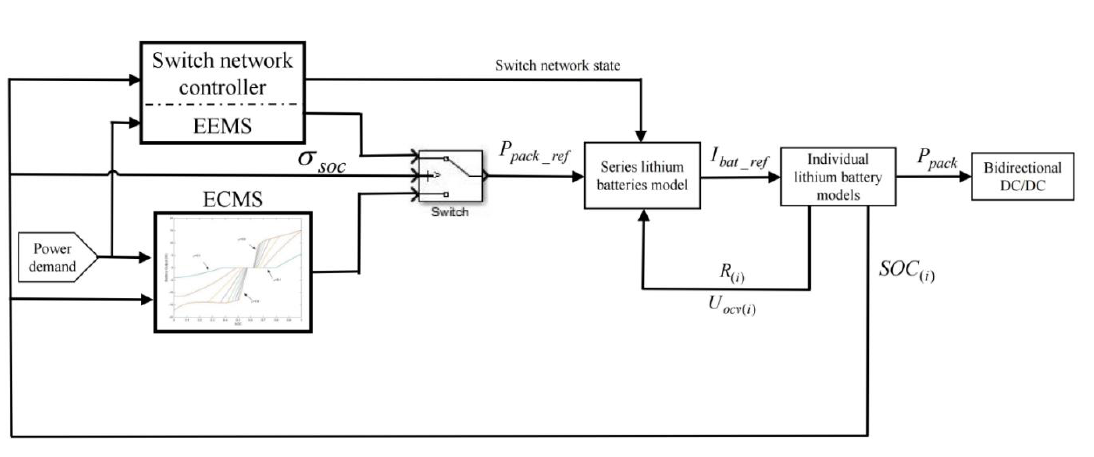
Figure 7. The structure of switch network.